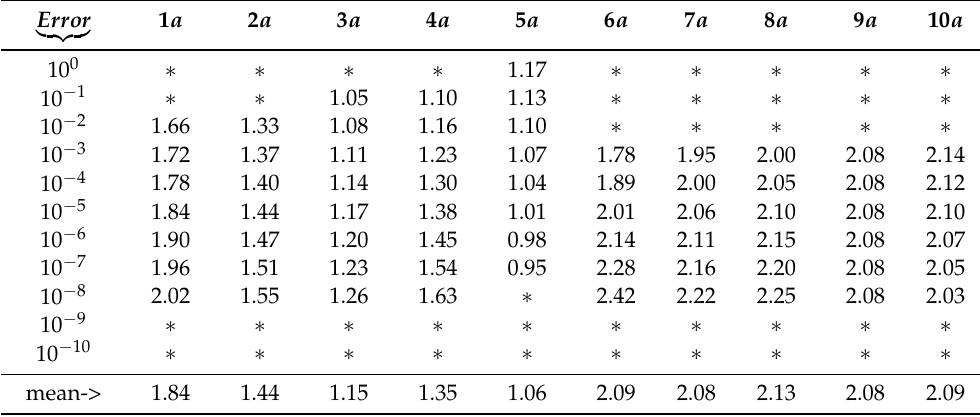
Table 9. Efficiency ratios of DP5(4) vs. NEW(4) for problems 1 a –10 a in the interval [ 0,20 π ] and global errors achieved over the whole integration interval. Stars indicate unavailability of data to attain the perspective